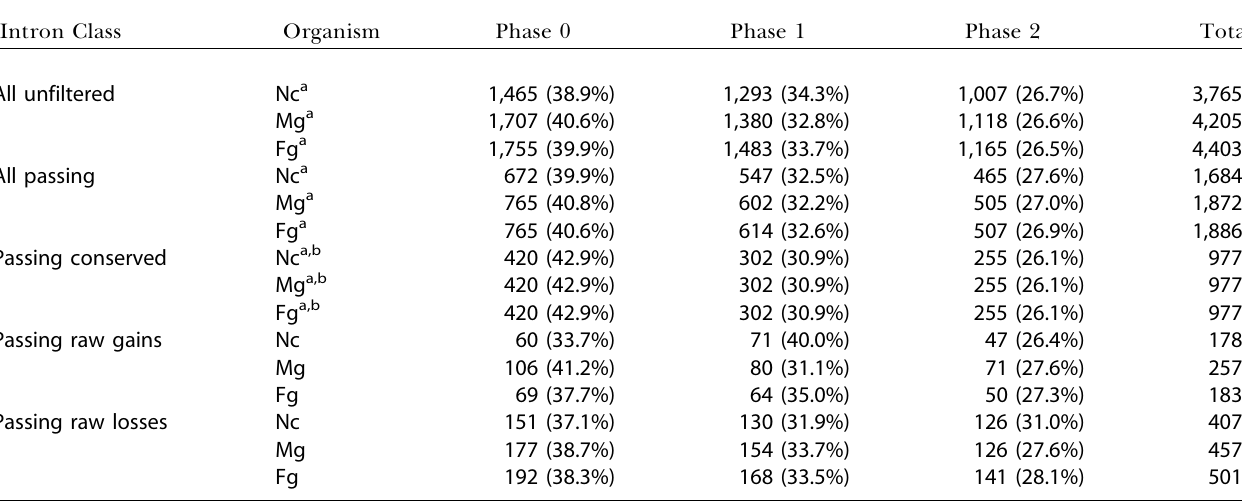
Table 1. Intron Phase Distribution for Filtering and Conservation Classes Intron